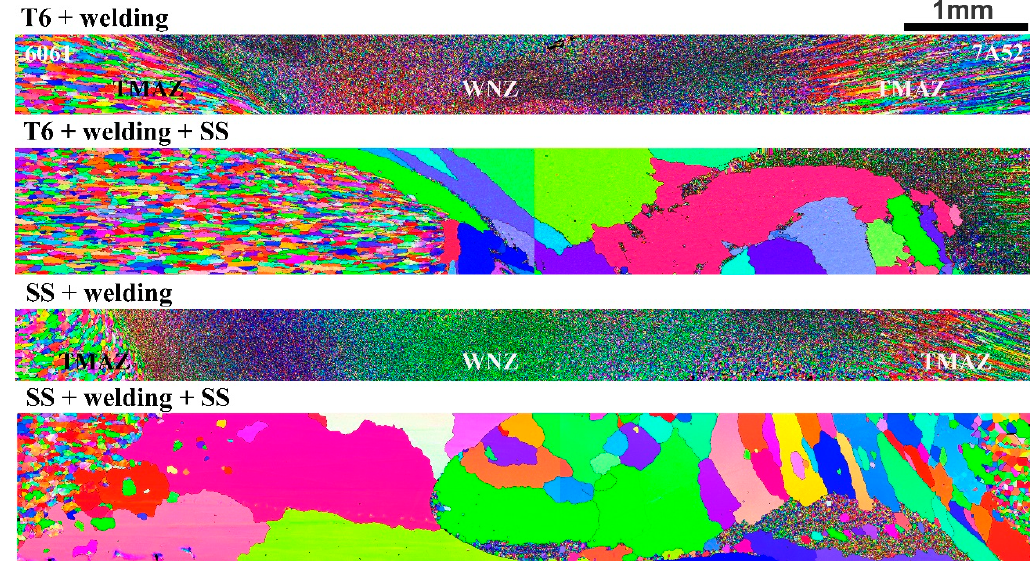
Figure 7. Electron back-scattered diffraction (EBSD) orientation map of grains in FSW joint of dissimilar 7A52 and 6061 alloys.